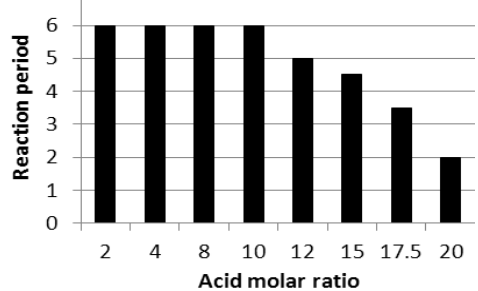
Figure 7. Relation between acetic acid molar ratio and reaction period Examining of adding small amounts of Lanthanum nitrate as structural modifier.